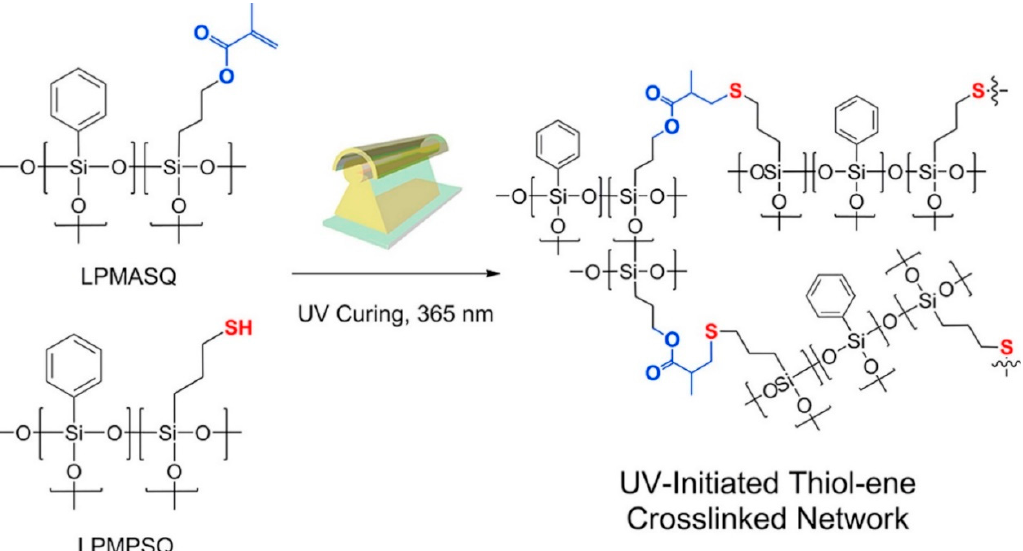
Figure 39. The synthesis of thermoplastic UV-curable polyphenylsilsesquioxanes. Reprinted/adapted with permission from Ref. [144]. Copyright (2015), with permission from Elsevier [144].